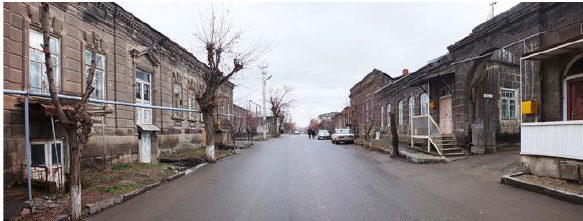
Figure 8. Vernacular ensemble of Spandaryan Street.